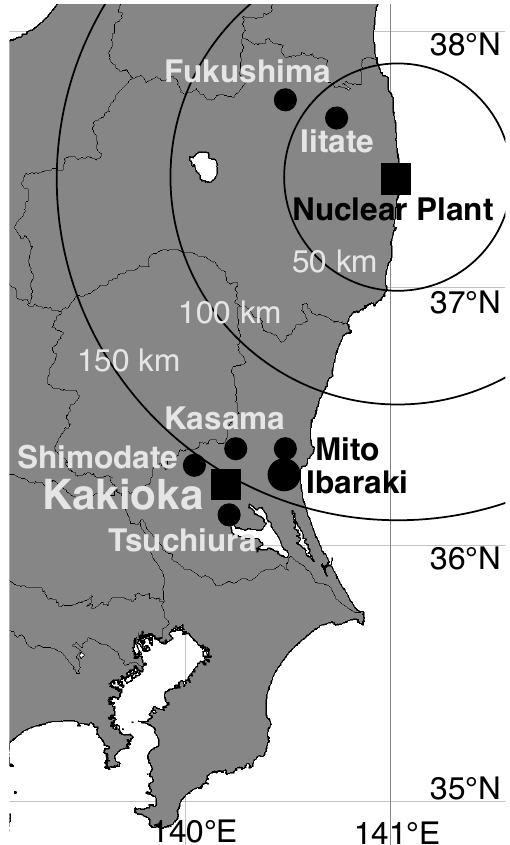
Fig. 2. The locations of the Fukushima Dai-ichi nuclear power plant (FNPP), Kakioka (150km southwest of FNPP), Ibaraki-cho (25km east of Kakioka), Mito (30km northeast of Kakioka), Kasama (17km north of Kakioka), Shimodate (19km west of Kakioka), and Tsuchiura (15km south of Kakioka). For reference, we add Iitate (40km northwest of FNPP) and Fukushima (60km northwest of FNPP), which are reported as highly contaminated re- gion compared to the region in the other direction for the same dis- tance from the FNPP.